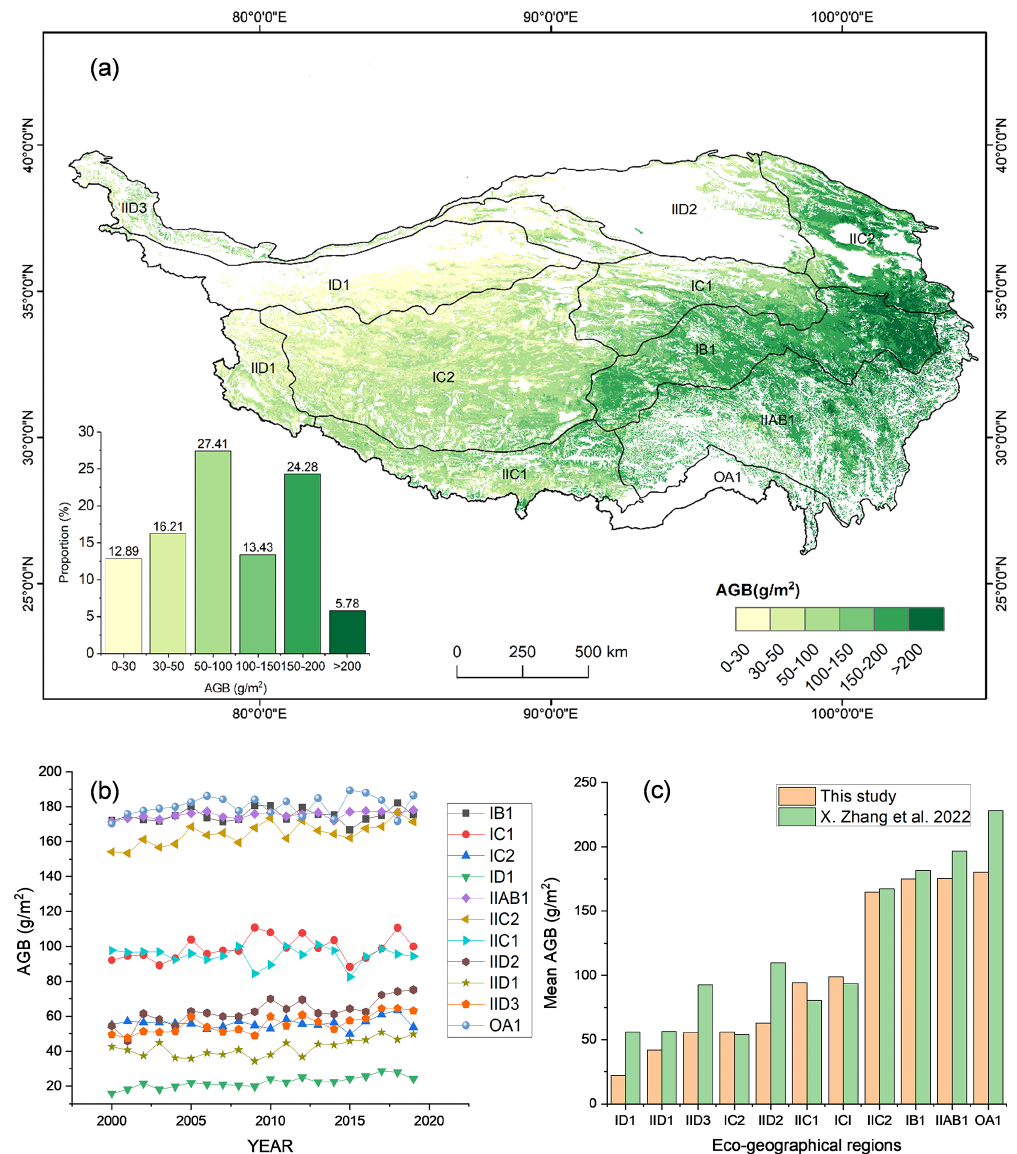
Figure 8. (a) The spatial distribution of average grassland AGB on the QTP from 2000 to 2019. IID1, IID2, IID3, ID, IIC1, IIC2, IC1, IB1 IIAB1, and OA1 are the eco-geographical regions of the QTP (Zheng, 1996). The full names of each eco-geographical region are listed in Table A5. (b) AGB values of each eco-geographical region from 2000 to 2019. (c) Comparison of multi-year AGB averages in the different eco-geographical